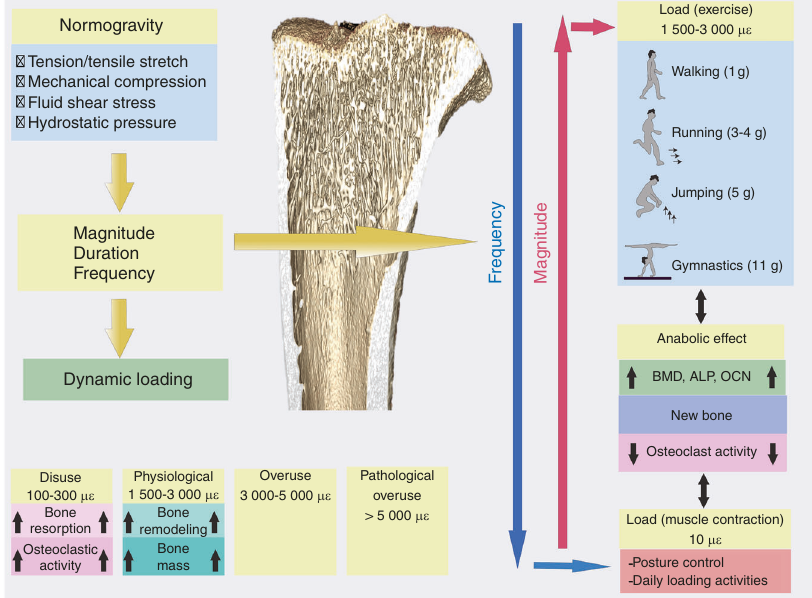
Fig. 4 A schematic showing the mechanical loads borne by bone in normogravity. με : microstrain, BMD: bone mineral density, ALP: alkaline phosphatase, OCN: osteocalcin. Several studies have suggested that the rate (determined by the frequency and amplitude) rather than the magnitude alone of the applied loading stimulus correlates with bone formation. 75,247 This implies that bone formation is enhanced by dynamic loading, and therefore, both the magnitude (or amplitude) and the frequency of loading are important parameters. It has been shown that low magnitude [<10 με (<1 g; 1 g = 9.8 m·s − 2 )] and high frequency (10 – 100 Hz) loading stimulate bone growth, inhibiting disuse osteoporosis. 248,249 Peak dynamic strain magnitudes within the physiological range of 1 500 – 3 000 microstrain ( μ ɛ ) are reported to result in bone modeling and an increase in mass. Strain within the disuse range of 100 – 300 μ ɛ activates osteoclastic activity and bone resorption. Strain levels above 3 000 μ ɛ are considered overuse, and those above 5 000 are considered pathological overload